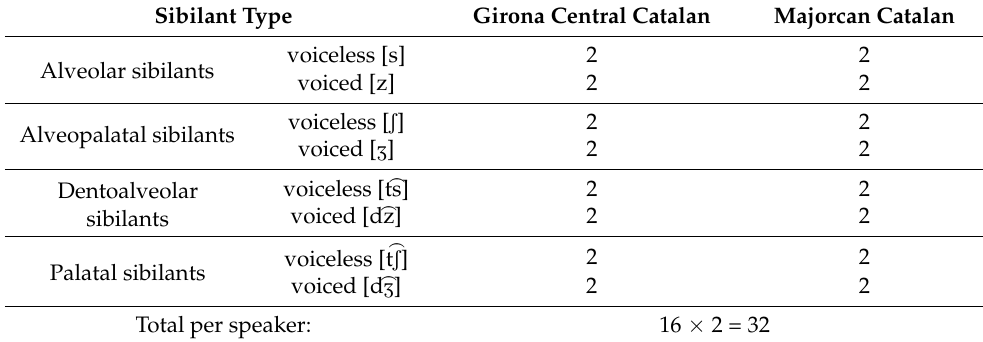
Table 2. Number of cases in the corpus for each sibilant, and number of utterances read by each speaker. Sibilant Type Girona Central Catalan Majorcan Catalan voiceless [s] 2 2 Alveolar sibilants voiced [z] 2 2 voiceless [ S ] 2 2 Alveopalatal sibilants voiced [ Z ] 2 2 > voiceless [t s] 2 2 Dentoalveolar > voiced [d z] 2 2 sibilants > S ] 2 2 voiceless [t Palatal sibilants > Z voiced [d ] 2 2 Total per